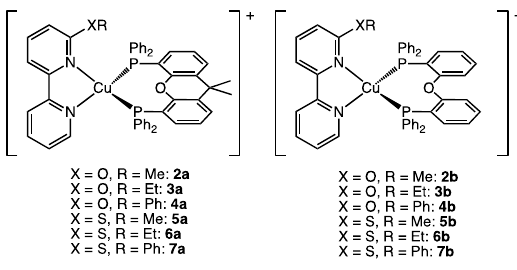
Figure 4. Structures of the [Cu(NN)(PP)] + cations reported in reference [26] and used in case study 1.